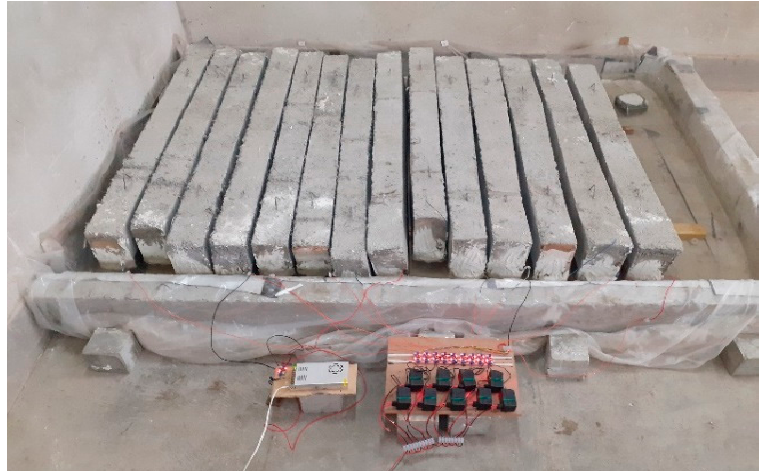
Figure 4. Accelerated corrosion of the prestressed concrete beams.